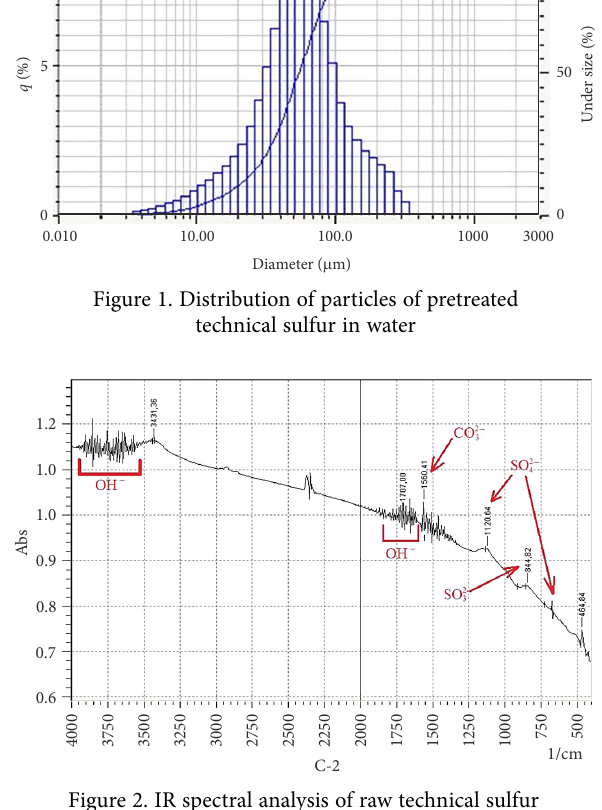
Figure 2. IR spectral analysis of raw technical